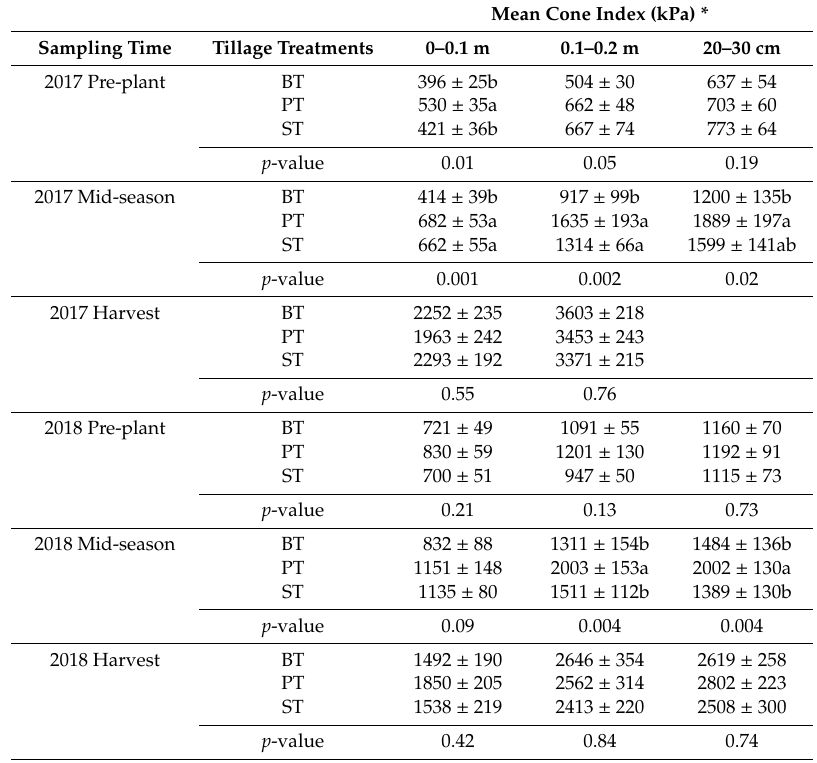
Table 4. Penetration resistance measurements under the tillage treatments tested in Las Cruces (2017 and 2018).